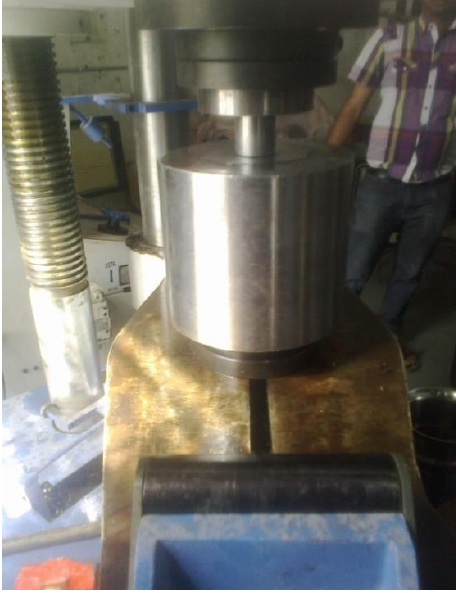
Figure 3. Compaction process on 1000 kN UTM using a cold isostatic compaction chamber.